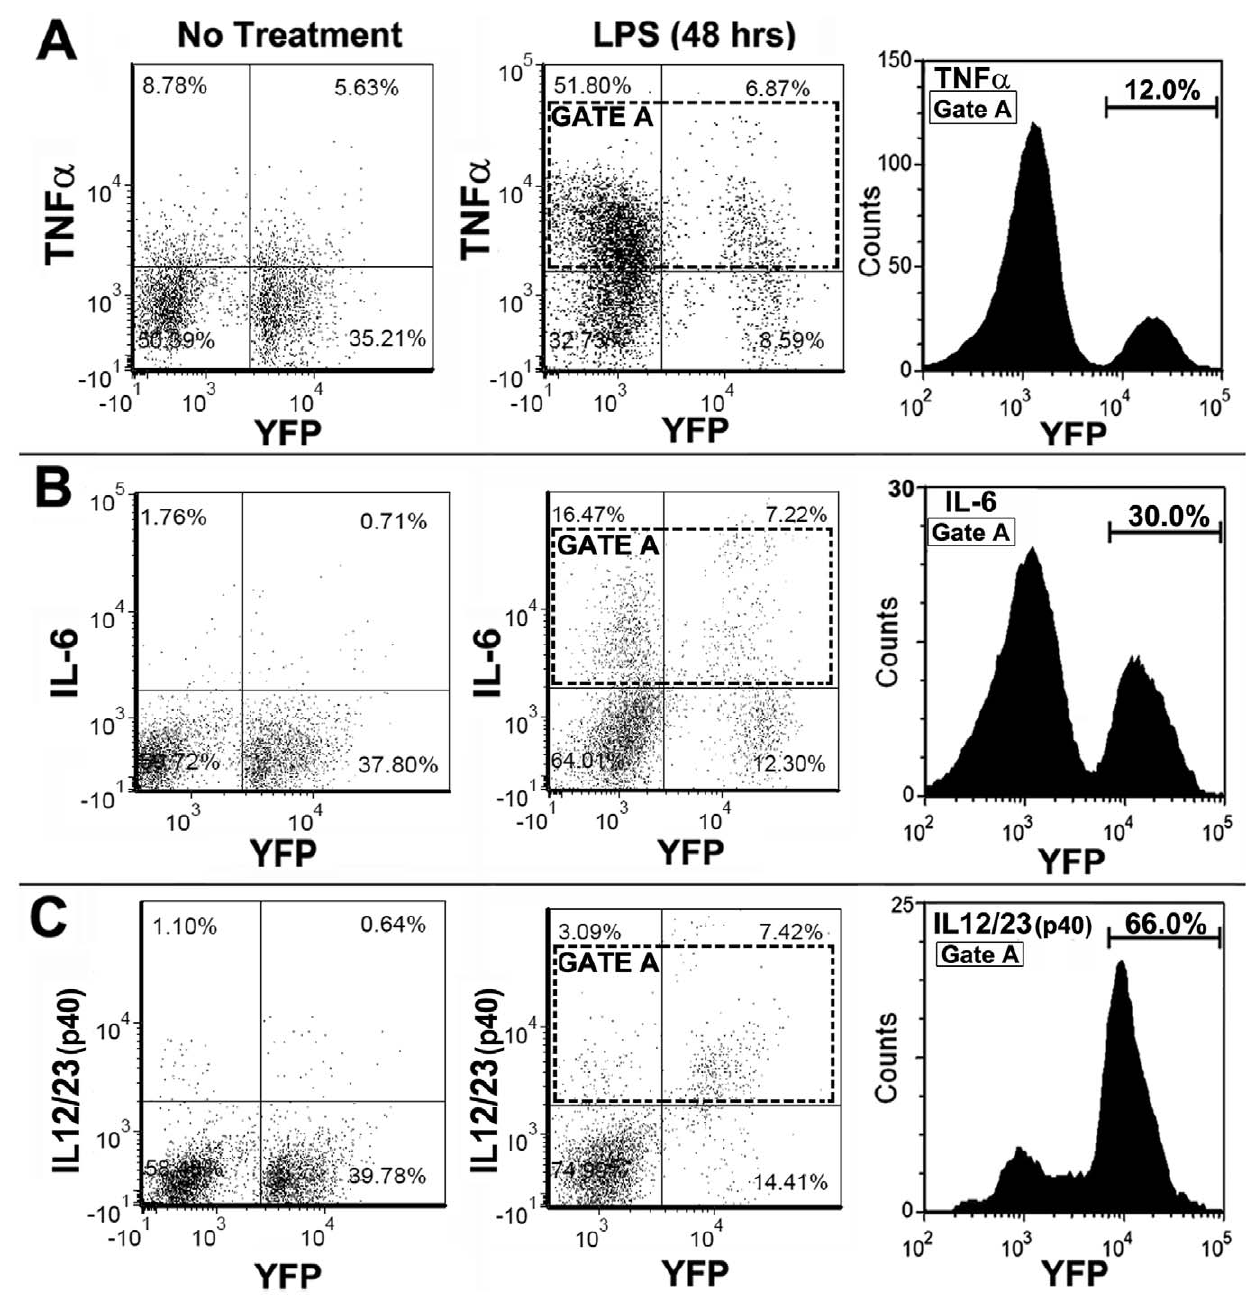
Figure 8. Production of inflammatory and anti-inflammatory cytokines by spleen cells of a 7 Cre:YFP mice stimulated with LPS. Intracellular cytokine measurements of cells isolated from spleens of a 7 Cre:YFP mice which were either non-stimulated (no treatment) or LPS injected (25 m g, 48 hr harvest) mice. (A) Intracellular TNF a , (B) Intracellular IL12/23(p40), and (C) Intracellular IL-6. The histograms represent percent of cytokine positive cells (Gate A) following LPS challenge. In all cases, LPS induces cytokine production was increased by LPS indicating a positive response by the animals. Histograms of TNF a + cells (Gate A) show, for example, that the a 7 lin– cells contribute the majority of the TNF a response of spleen cells to LPS stimulation. Analyses for IL-12/23(p40), and IL-6 are shown in B, and C. IL-12/23(p40) contribution is predominantly from a 7 lin + cells while the contribution of a 7 lin + to IL-6 is also substantial (30%). These experiments were repeated 3 times with similar results.